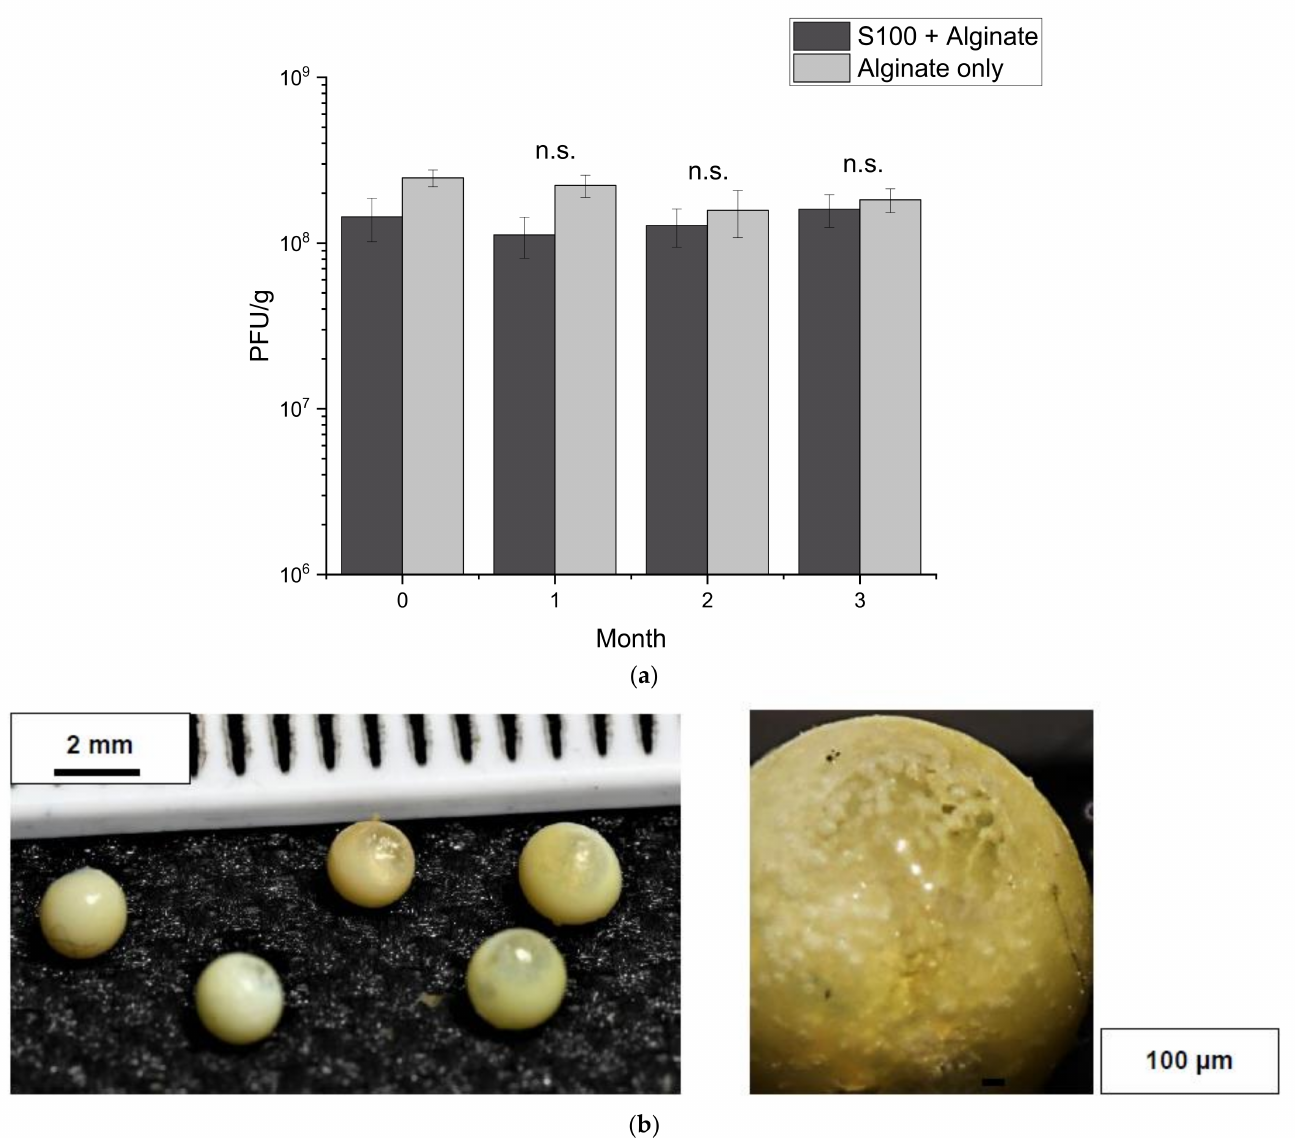
Figure 6. Storage stability of core-shell capsules. Capsules were stored dry in either refrigerated (4 ◦ C) or room temperature (21 ◦ C) conditions. ( a ) Monthly, samples were taken, and the phage titre was enumerated using the plaque assay. Error bars represent one standard deviation. * A paired t -test comparing each month to the initial phage titre) was completed, ‘n.s.’ refers to no significant difference ( p > 0.05). ( b ) Discolouration of S100 + alginate shelled capsules stored at room